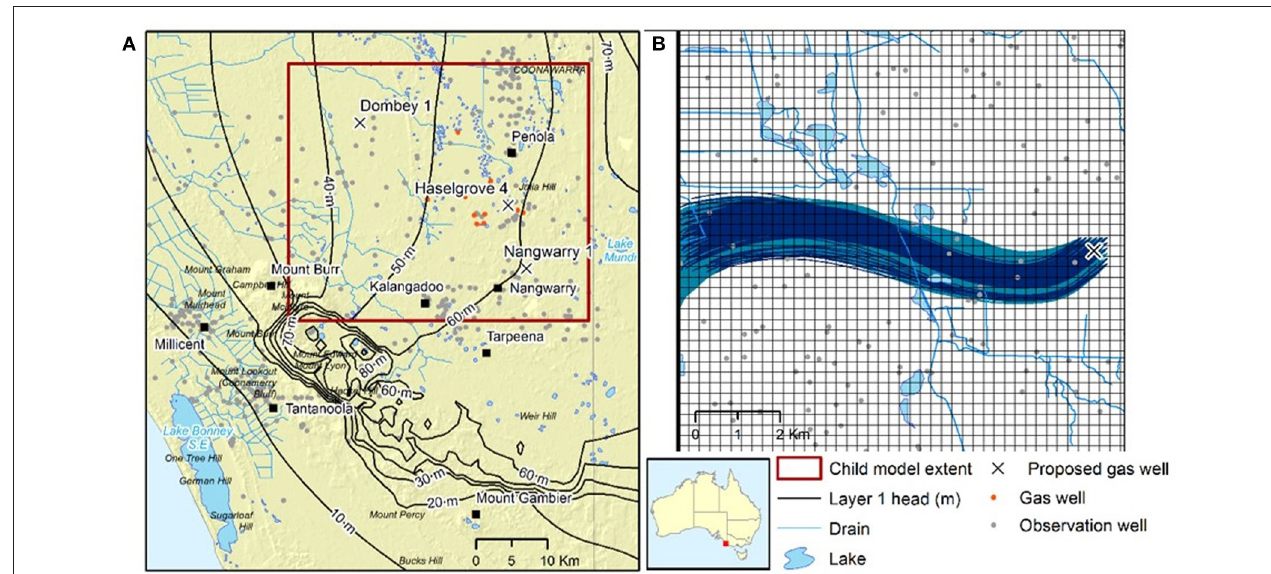
FIGURE 3 | (A) Case study location, child model domain, water features, gas wells, and hydraulic heads in the Tertiary Limestone Aquifer; (B) particle flow